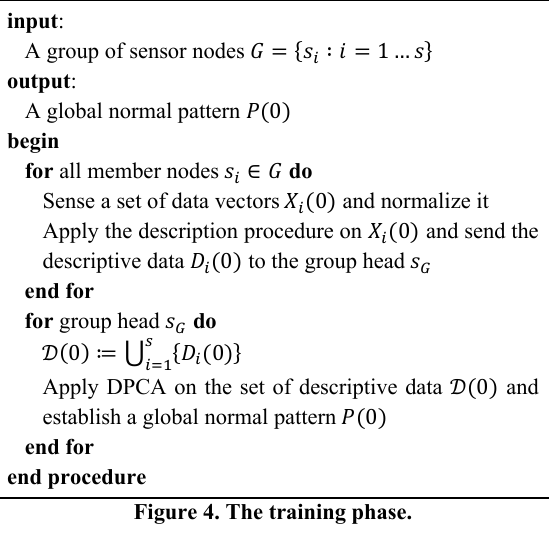
Figure 4. The training phase.